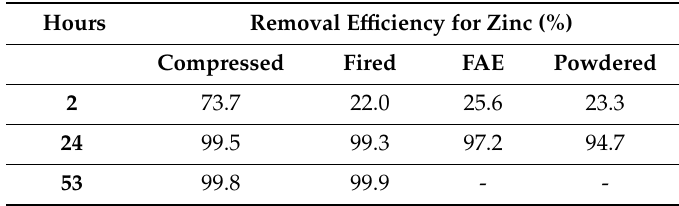
Table 2. E ffi ciency of the di ff erent pellets for adsorbing Zn at 2, 24 and 53 h